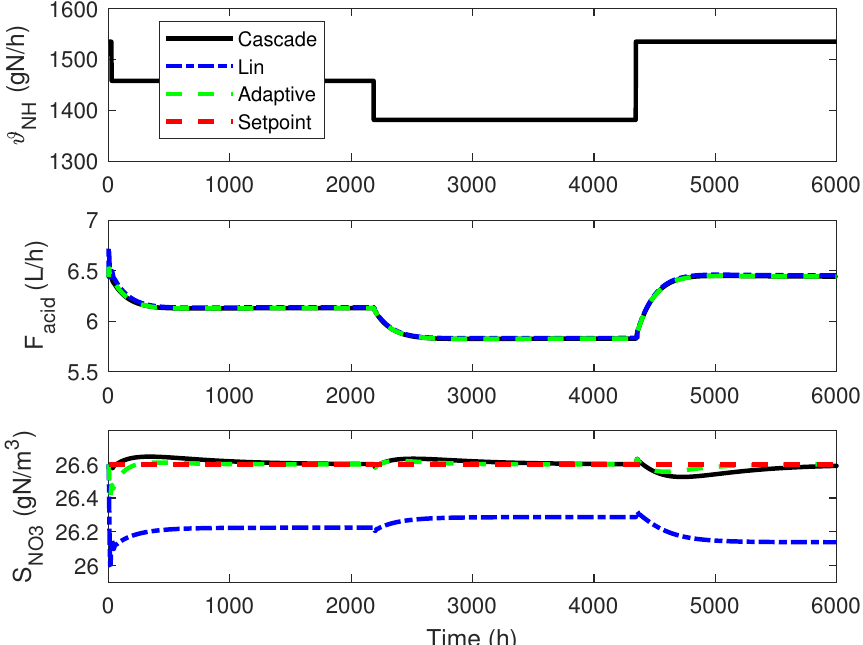
Figure 15. Nitrate concentration and acid flowrate evolutions for 5 to 10% variations in ammonia (waste) production ( ϑ S ) using different controllers: cascade ( Cascade ), classical linearizing ( Lin ) and NH adaptative linearizing controllers ( Adaptive ).